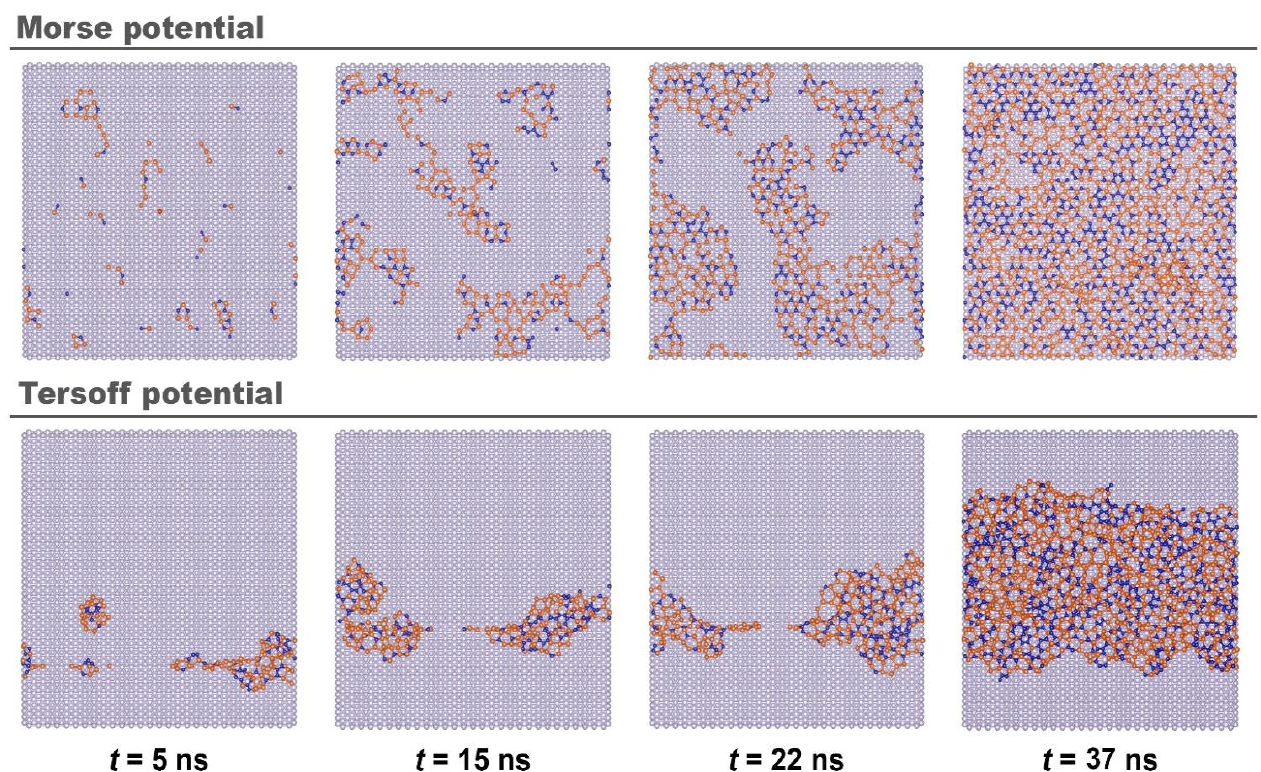
Figure 3. Stages of growth of SiC films on a graphite substrate in the description of the “film-substrate” interaction by the Morse potential ( top ) and Tersoff one ( bottom ).